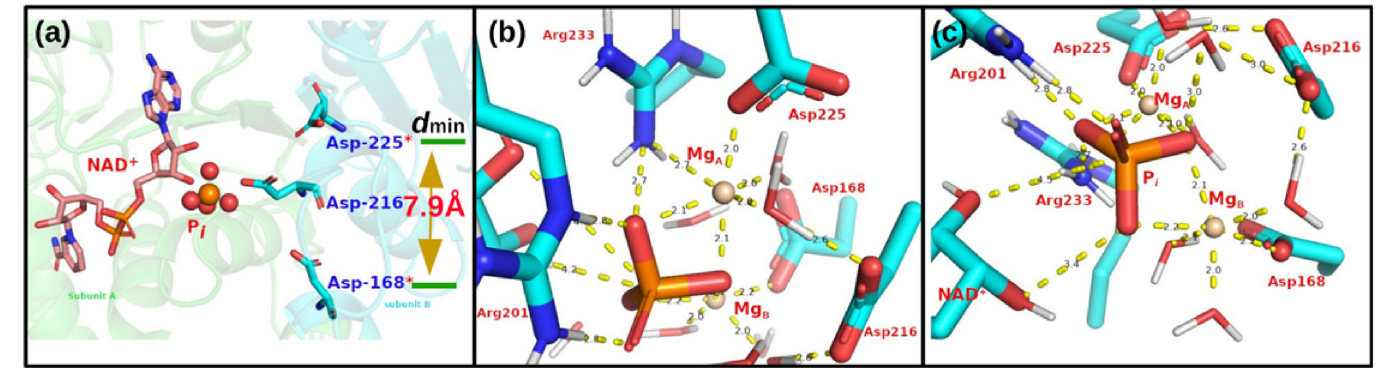
Fig 3. (a) NAD + and P i binding site from the X-ray structure (6KG2.pdb). Each monomer is labeled as subunit A (green) and B (cyan), respectively. Asp168, Asp216 and Asp225 from subunit B are colored as cyan for C atoms and shown as sticks. The minimum distance between Asp168 and Asp225 is 7.9 Å . (b) The Mg A binding pocket. (c) The Mg B binding